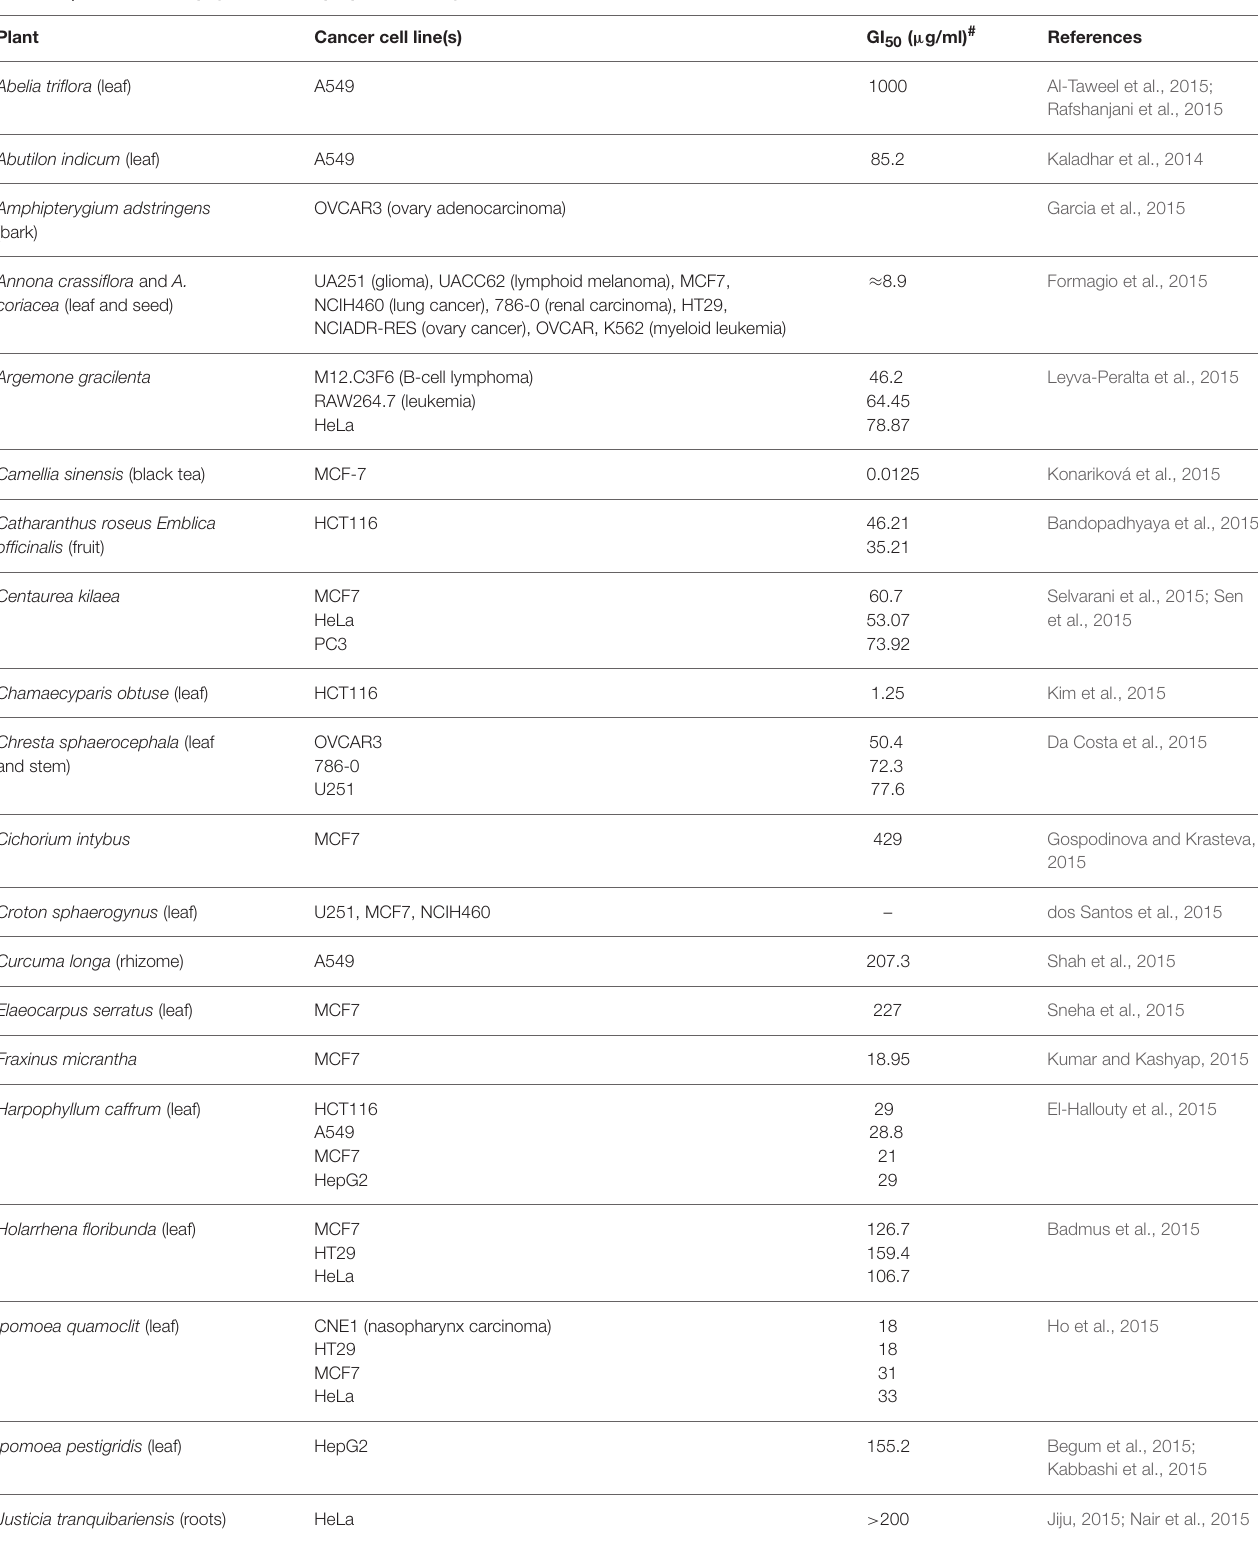
TABLE 5 | Plants whose phytochemical preparation is cytotoxic toward cancer cell lines.